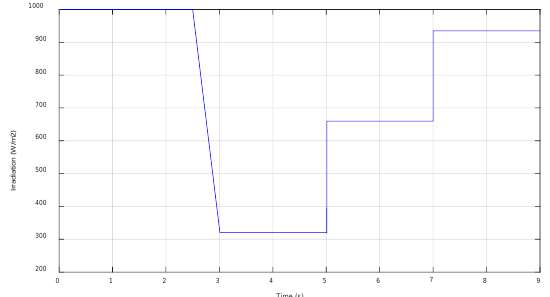
Figure 9. Irradiance variation during simulation. Table 3. Simulation parameters.